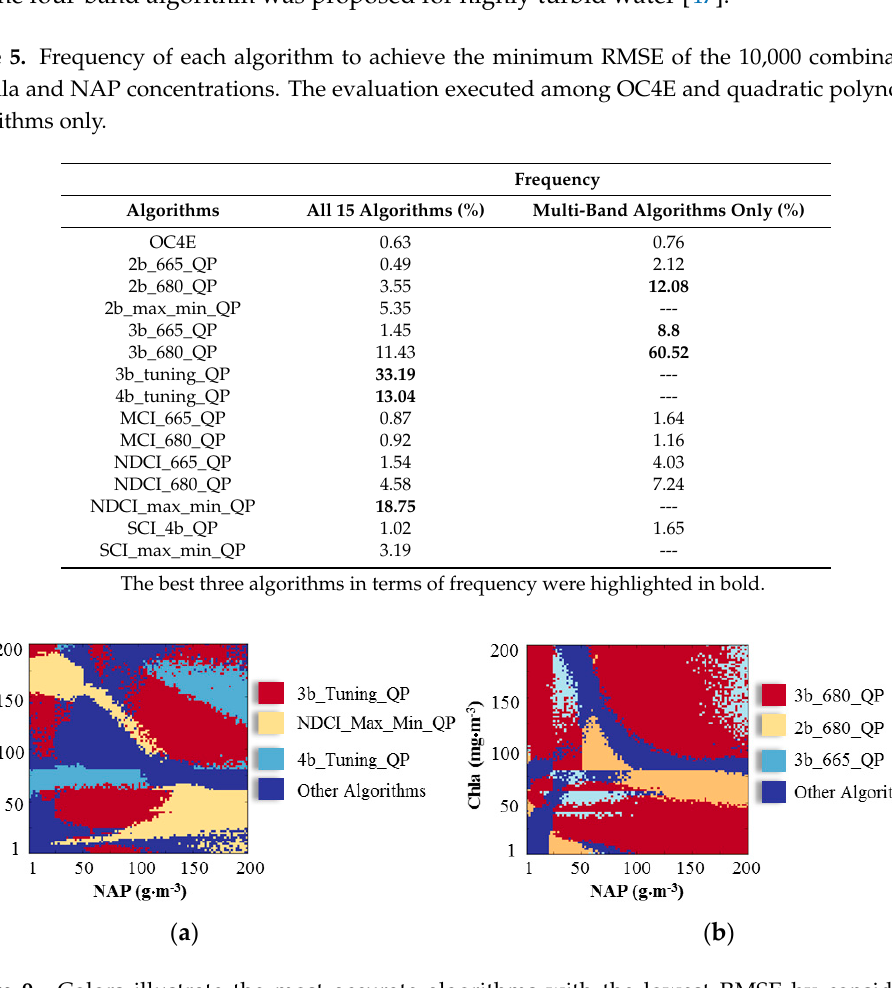
Figure 9. Colors illustrate the most accurate algorithms with the lowest RMSE by considering the chlorophyll- a (Chla) and non-algal particles (NAP) concentrations. The OC3E and quadratic polynomial algorithms were only compared (i.e., 15 algorithm combinations). ( a ) Top 3 algorithms of the 15 algorithm combinations; and ( b ) Top 3 algorithms of 10 multi-band algorithm combinations.